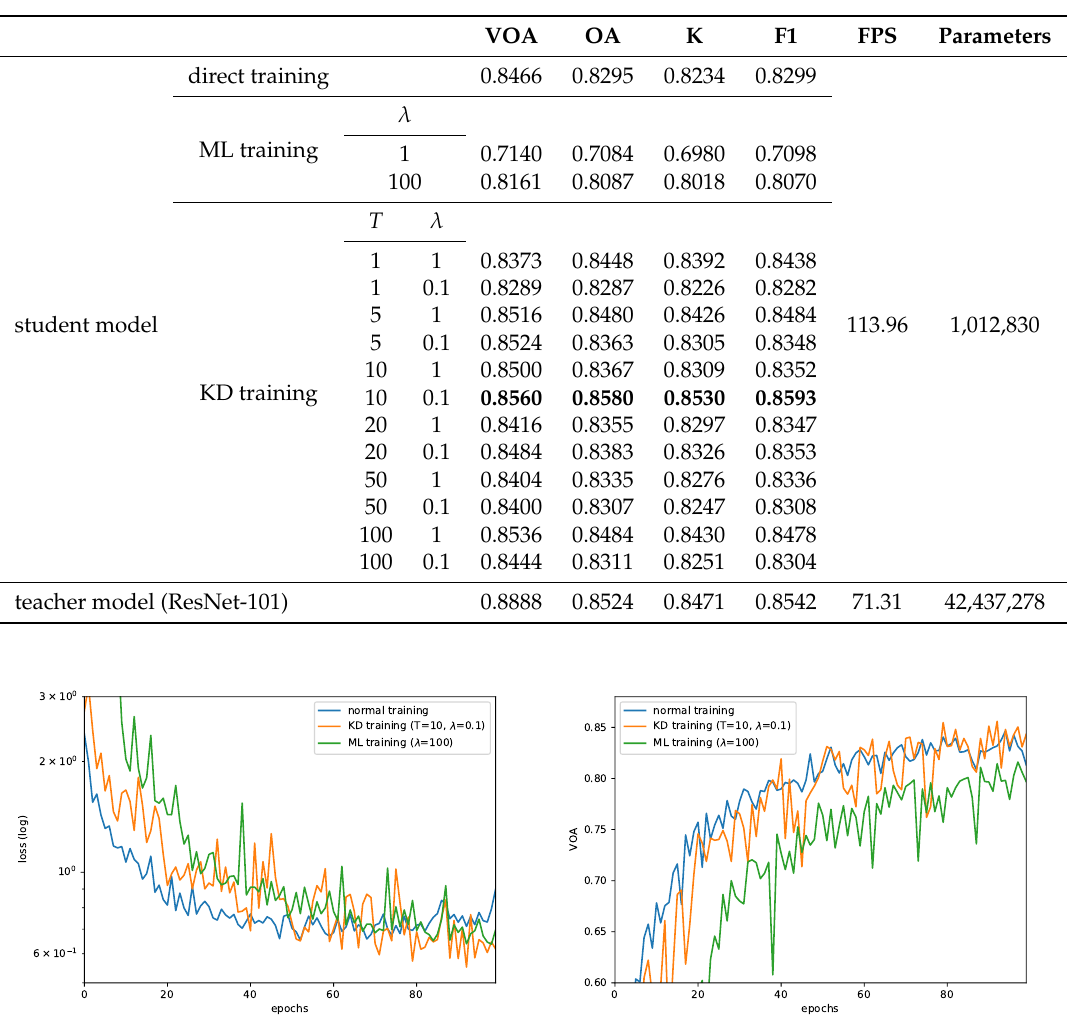
Table 3. Results of Knowledge Distillation training experiments on AID dataset.